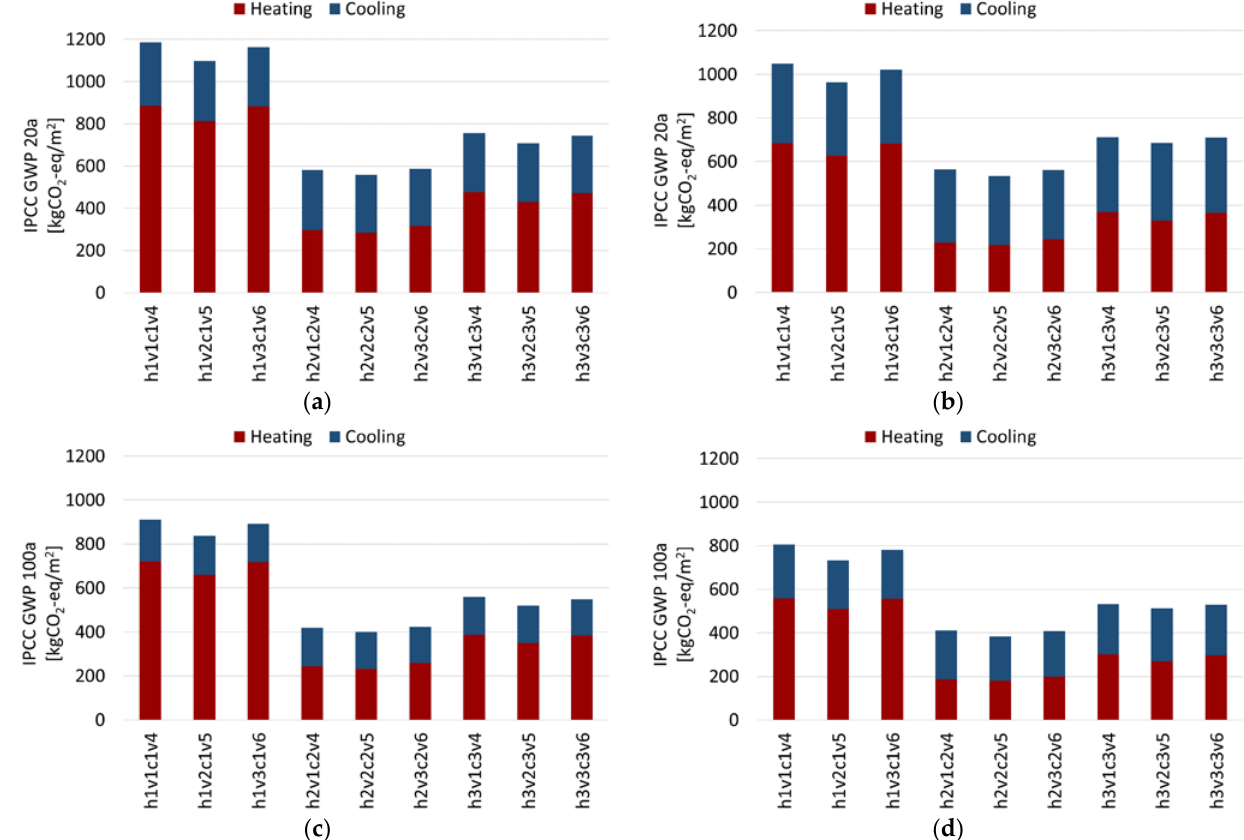
Figure 8. Comparison of the annual results per m 2 of floor area (manufacturing and disposal + operational stage) for heating and cooling calculated: using the indicator IPCC GWP 20a with ( a ) LCA b ; and ( b ) LCA cc ; and using the indicator IPCC GWP 100a with ( c ) LCA b ; and with ( d ) LCA cc .